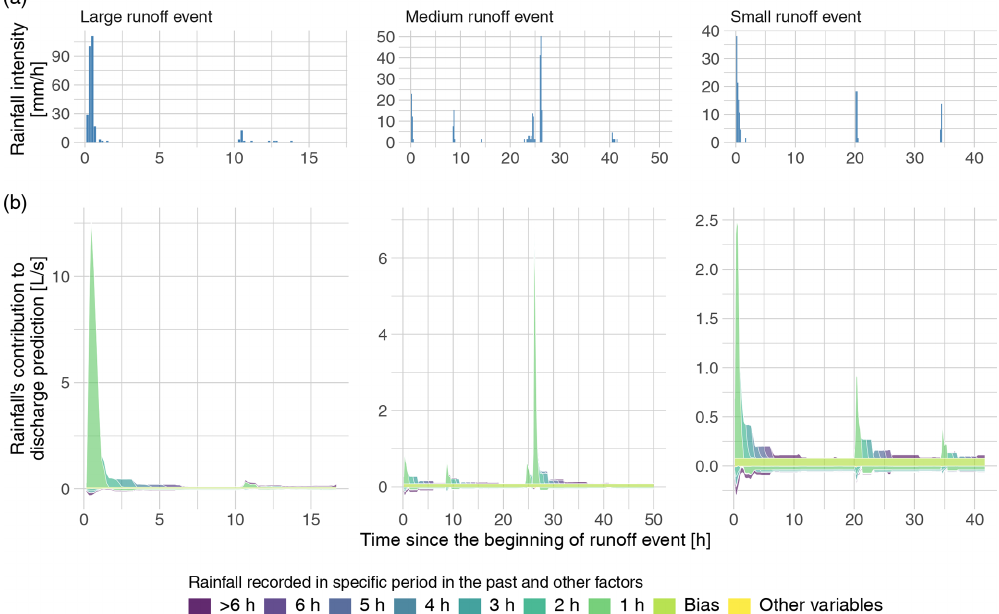
Figure 6. (a) Rainfall time series and (b) decomposed hydrographs of a large, medium, and small runoff event from the Washington Street SuDS site (WS). The model used to derive the hydrographs was obtained in the outer cross-validation iteration 1. Observational SHAP values were used in the